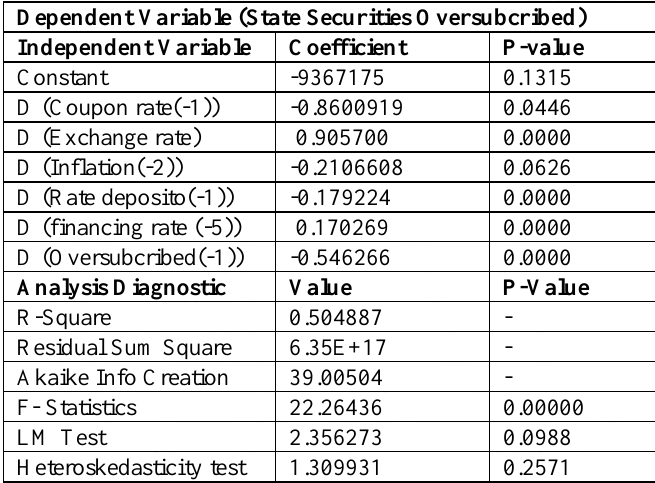
Dependent Variable (State Securities